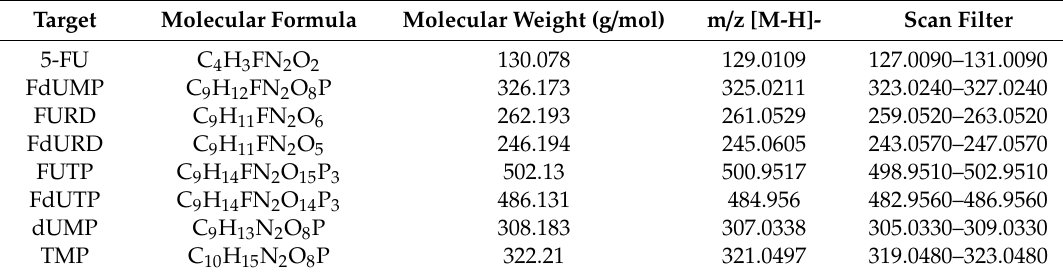
Table 2. List of target compounds. Precursor m / z calculated using isotope simulation and filter applied to visualize their fragments in Xcalibur Qual